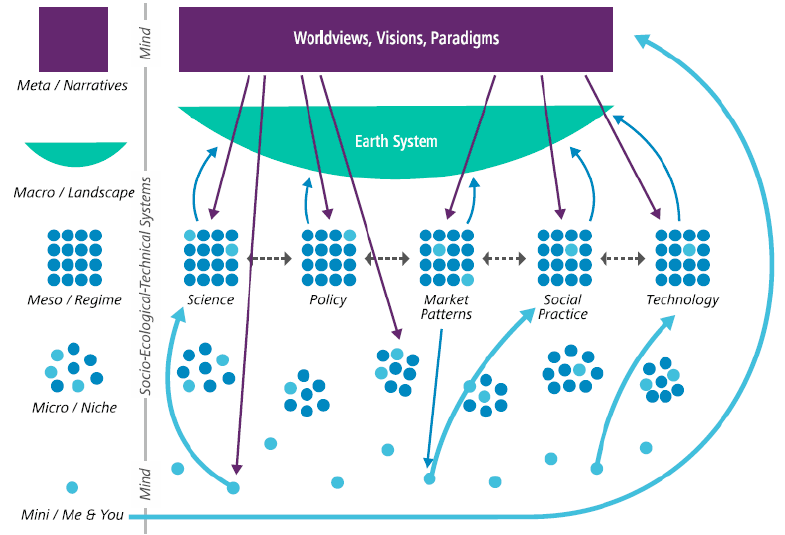
Figure 2. Mind-sets in the Multi-Level Perspective on transformations ([39] (47)) Sections 3.3.1–3.3.3.